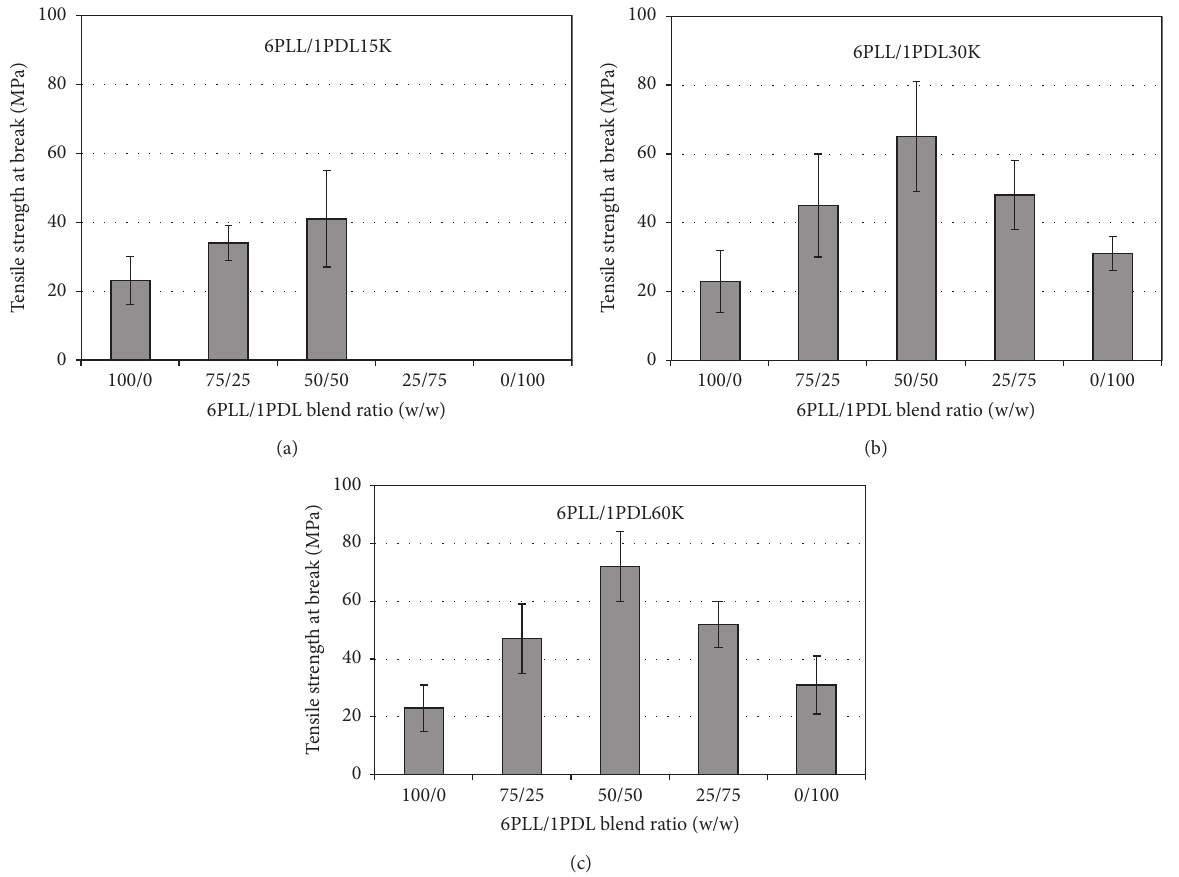
Figure 5: Tensile strength at break of 6PLL, 1PDL, and 6PLL/1PDL stereocomplex films prepared with different 1PDL molecular weights and 6PLL/1PDL blend ratios.